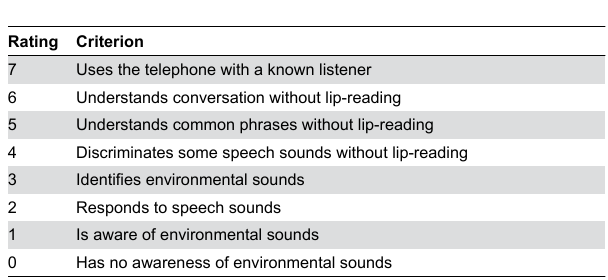
Table 4. Categorical Auditory Performance (CAP) criteria.